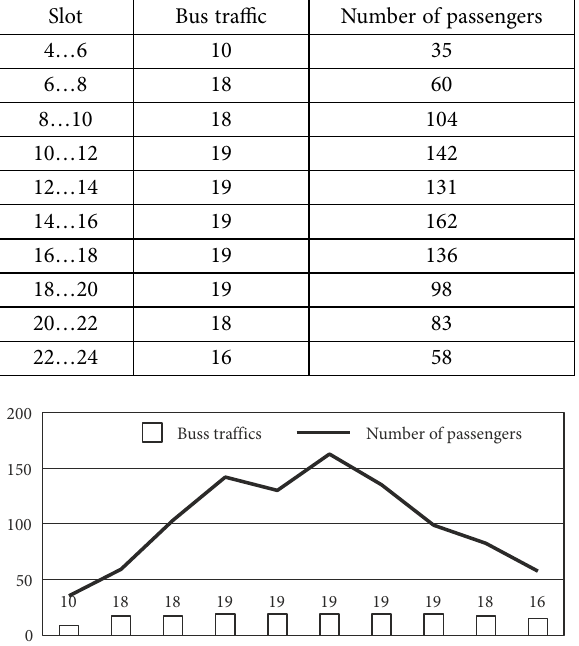
Table 3. Bus traffic and number of passengers by time of day